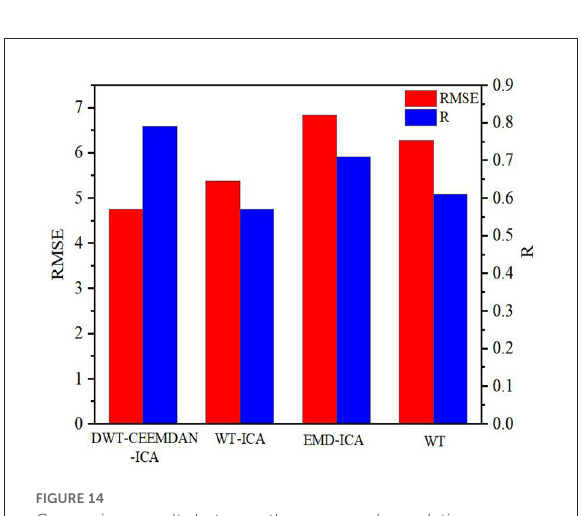
FIGURE14 Comparison results between the errors and correlation coefficients of each